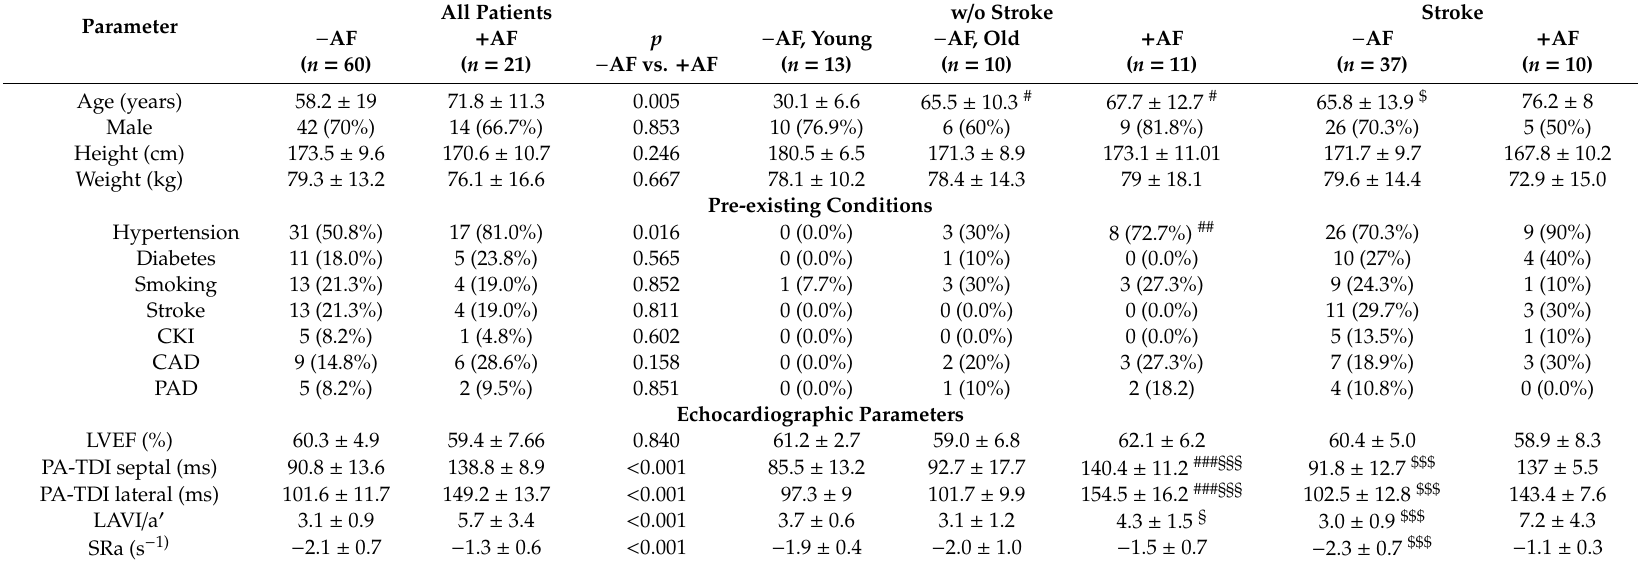
Table 2. Patient characteristics and echocardiographic